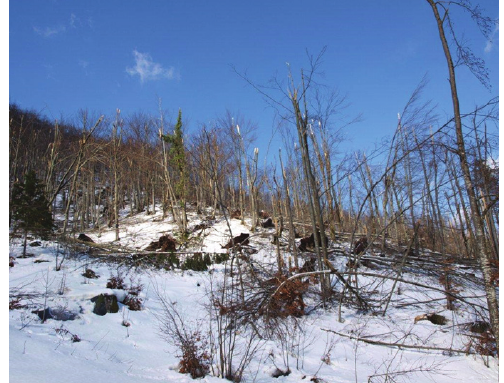
FIGURE 3. Completely destroyed forest